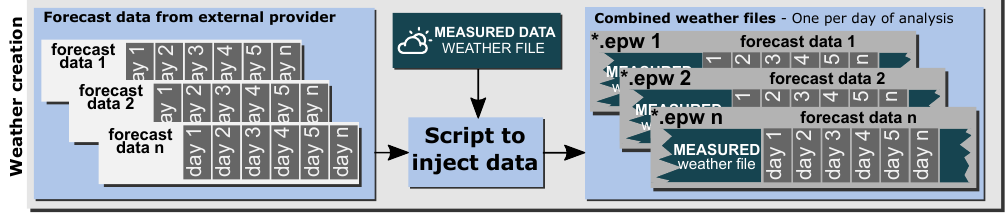
Figure 2. Weather file creation methodology.